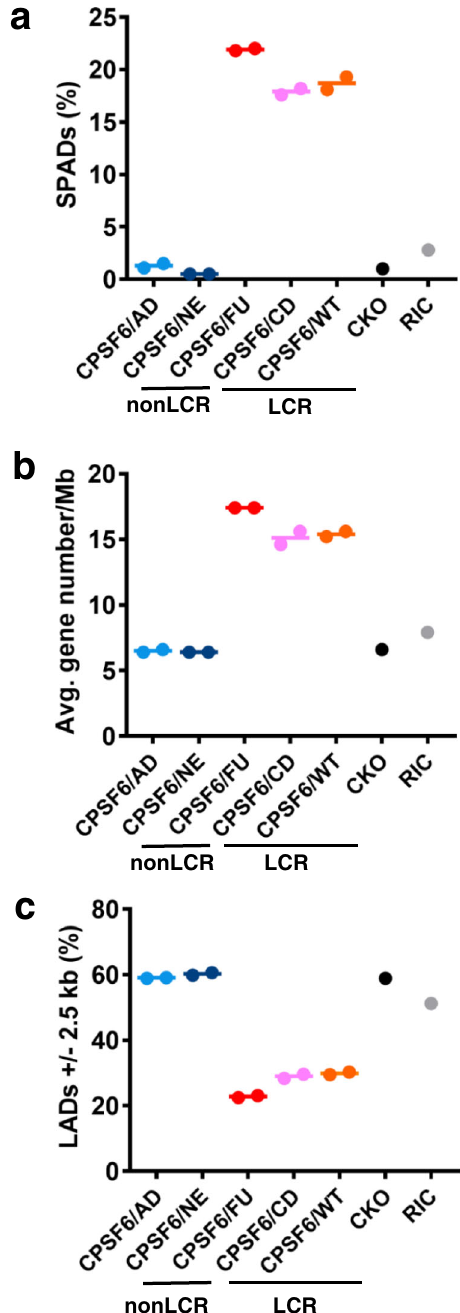
Fig.4|TheCPSF6LCReffectsonintegrationsiteselection. DistributionofHIV-1 integration sites in SPADs ( a ), gene dense regions ( b ), and LADs ( c ). CPSF6/AD, CPSF6/NE, CPSF6/FU, and CPSF6/CD constructs were expressed alongside WT CPSF6 (CPSF6/WT) in CKO cells. The random integration control (RIC) was pre- viously described 25 . With the exception of CKO cells, all experiments were done in duplicate. Data points from two independent experiment are shown and corre- sponding mean values are indicated by lines (also see Supplementary Table 2). Source data are provided as a Source Data fi le. CPSF6/AD CPSF6/ADD2, CPSF6/NE CPSF6/NEURM, CPSF6/FU CPSF6/FUS, CPSF6/CD CPSF6/CDK19, CPSF6/WT CPSF6/wild-type CPSF6, CKO CPSF6 knock-out, LCR low complexity